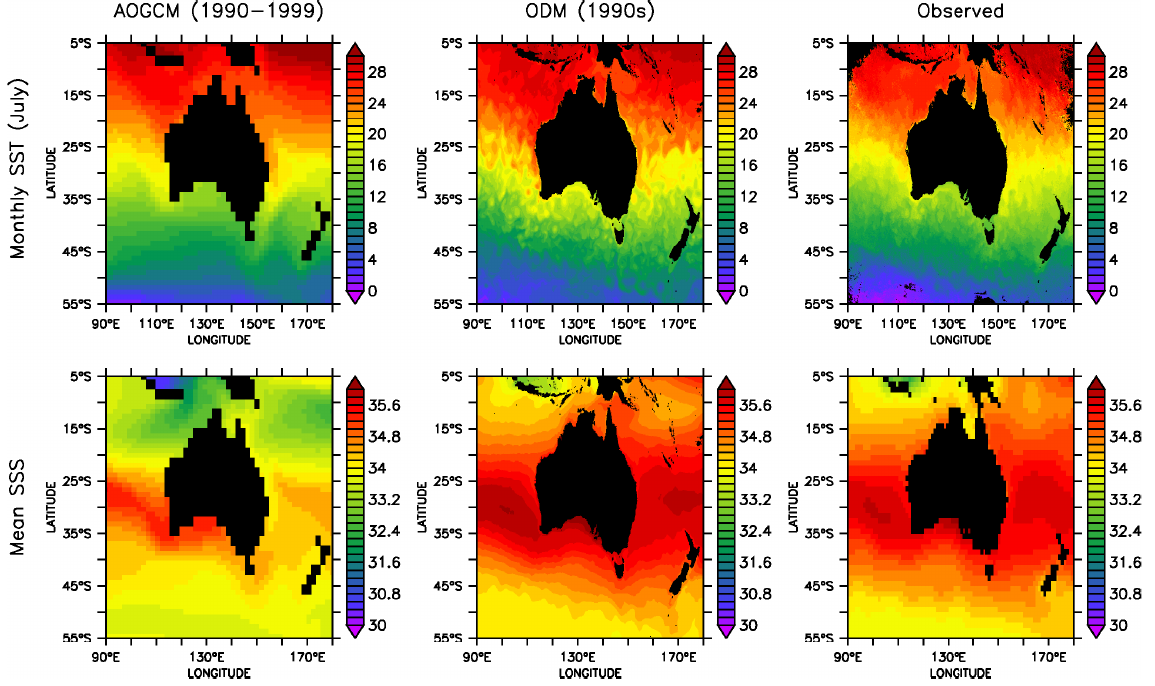
Fig. 3. Monthly snapshots of SST (top row, ◦ C) and mean sea surface salinities (bottom, practical salinity units – psu) for AOGCM, ODM and satellite AVHRR (Advanced Very High Resolution Radiometer) observations with the present